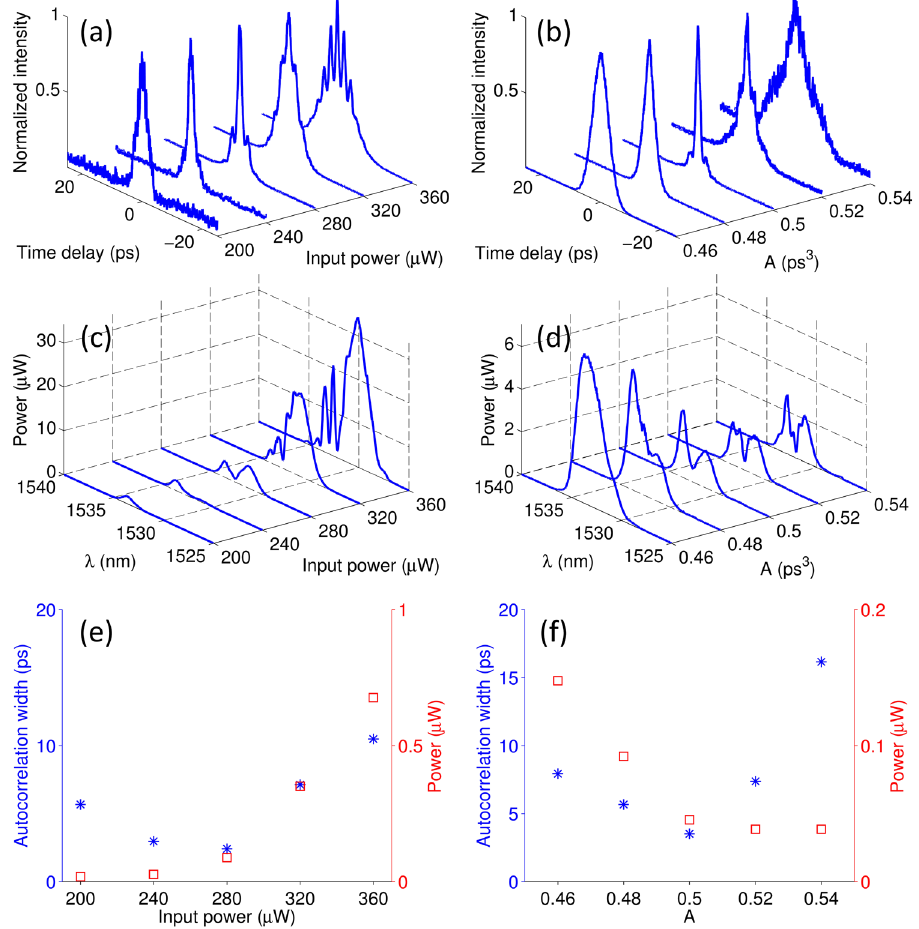
Figure 5. Experimental results of DW control using different input powers (left column) and depths of cubic phase modulation A (right column). The top and middle rows show the measured autocorrelation traces and spectra, respectively. In ( c ), the power of the DW spectrum becomes larger as a result of an enhanced main lobe compression of the Airy pulse - caused by a higher pump power. In ( d ), larger A values yield to a decreased peak power of the Airy pump, which leads in turn to reduced DWs powers. ( e ) and ( f ) correspond to ( a , c ) and (b , d ), respectively. Here, both the width of the autocorrelation trace (measured at the e − 1 level of the maximum intensity) and the corresponding DWs powers extracted from the spectral measurements are